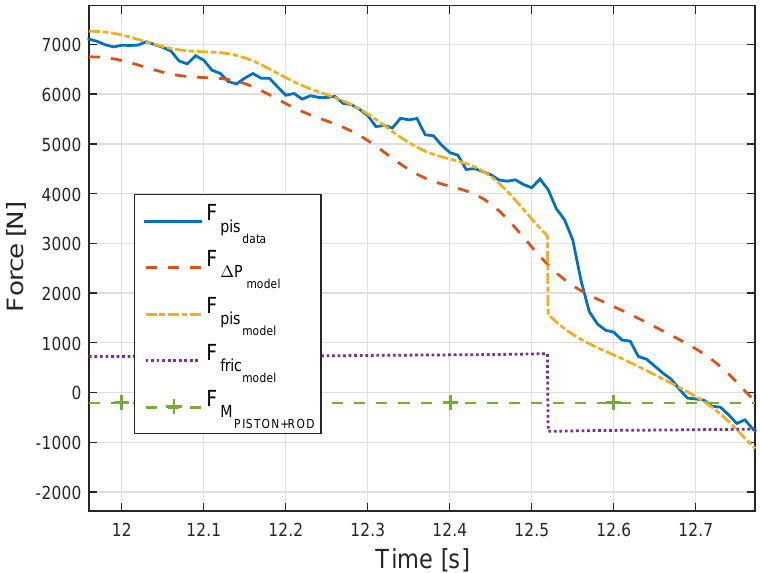
Figure 17. The effect of friction force at low velocity, comparing measured piston force and the contribution of the different effects obtained from the numerical model for the variable-pressure